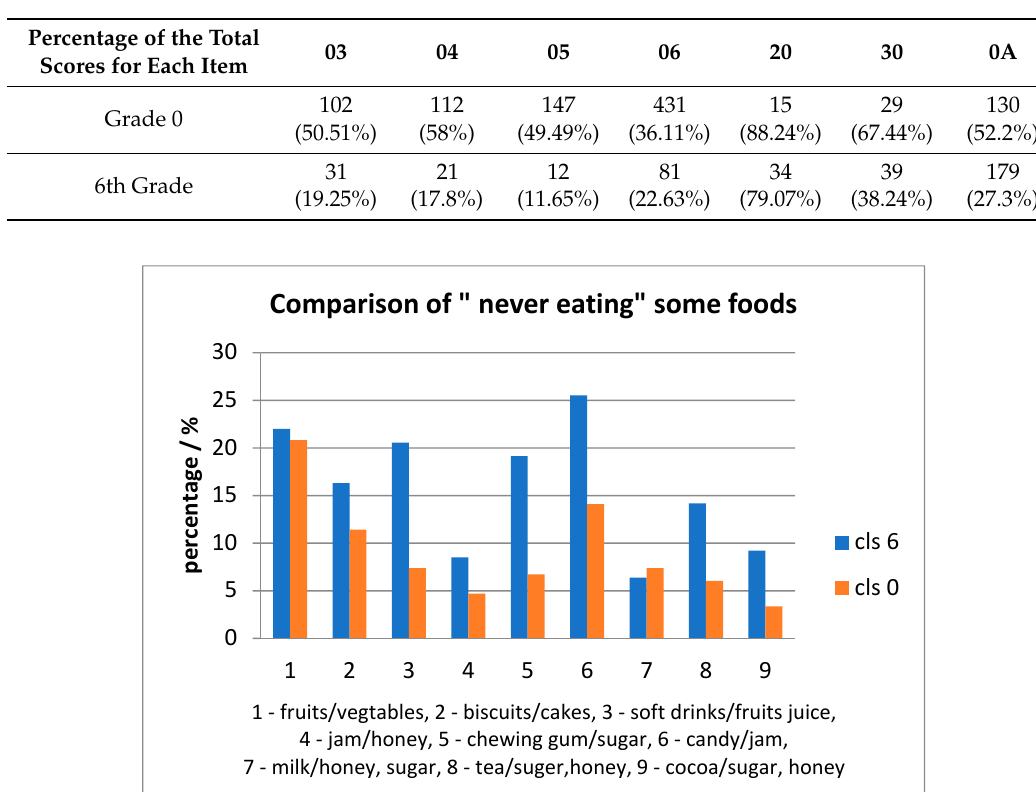
Figure 9. Comparison of “never eating “foods between 6- and 12-year children.